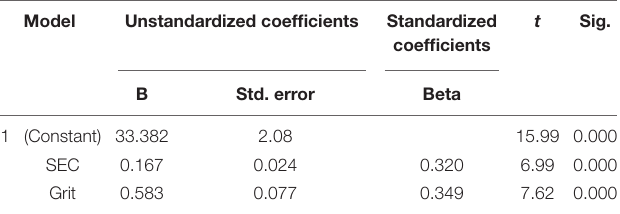
TABLE 8 | Coefficients for SEC, grit, and